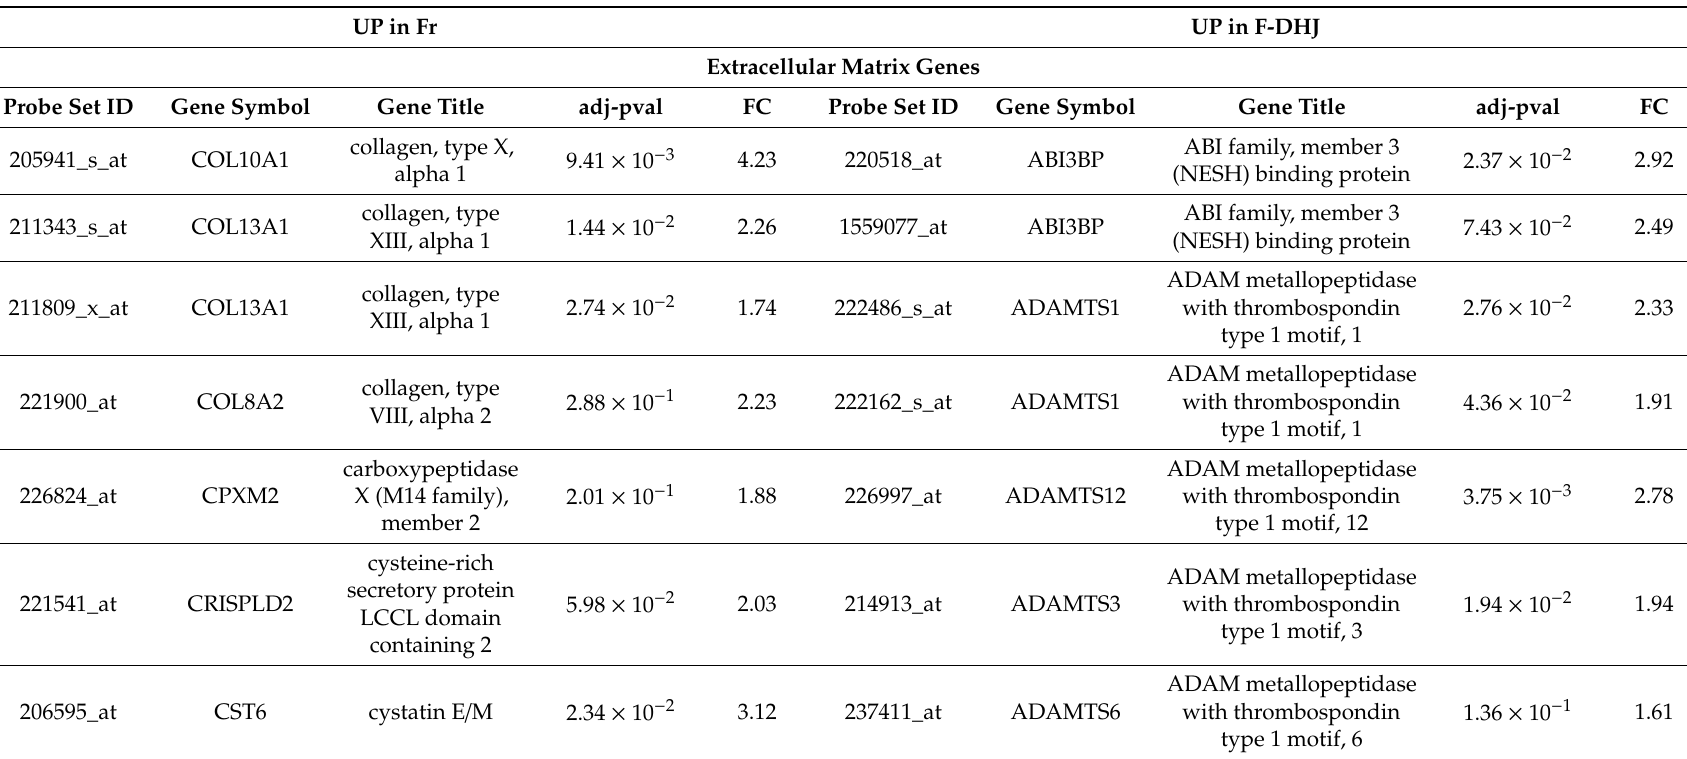
Table 3. Transcripts related to the tissue skeleton di ff erentially expressed in reticular dermis fibroblasts (Fr) and dermo-hypodermal junction fibroblasts (F-DHJ). This transcript list was extracted from microarray data using a fold-change > 1.5 and p < 0.05 as inclusion parameters. The transcript signature with predominant expression in Fr cells concerned 297 probe sets corresponding to transcripts directly involved in the tissue skeleton structure, comprising 33 transcripts related to the extracellular matrix (ECM), 125 focal adhesion point transcripts, 60 cytoskeleton transcripts, 1 LINC complex transcript, and 8 nucleoskeleton transcripts. The transcript signature with predominant expression in F-DHJ cells concerned 359 probe sets corresponding to transcripts directly involved in the tissue skeleton structure, comprising 94 transcripts related to ECM, 76 focal adhesion point transcripts, 50 cytoskeleton transcripts, 1 LINC complex transcript, and 7 nucleoskeleton transcripts. In addition, transcripts encoding soluble factors were found in both signatures, respectively 70 and 131 for Fr and F-DHJ